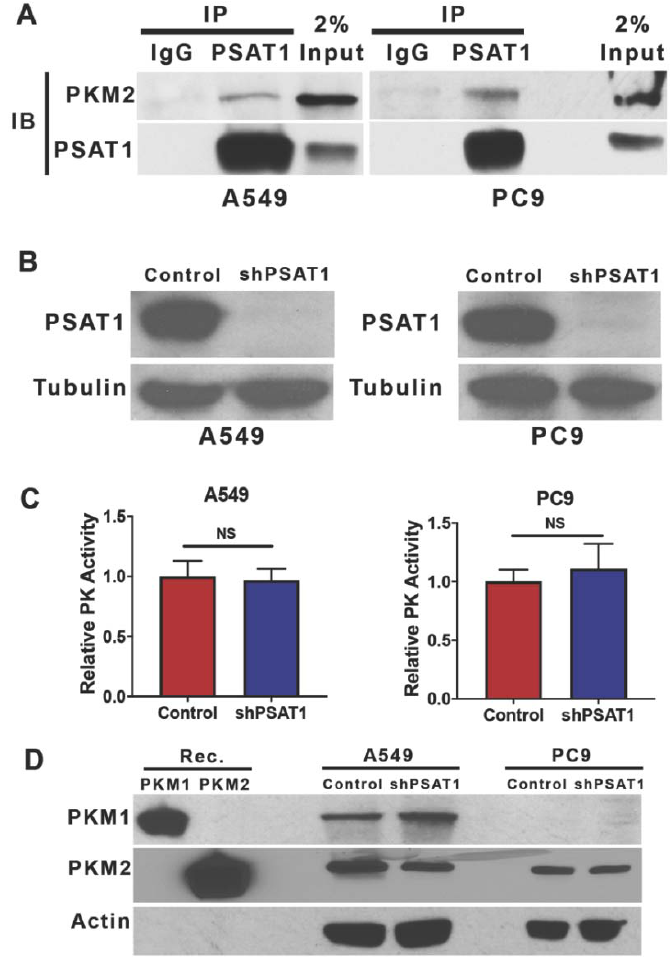
Figure 3. PSAT1 associates with endogenous PKM2 in NSCLC cells but the loss of PSAT1 does not alter either PKM2 expression or pyruvate kinase activity. ( A ) Co-IP of PSAT1 and PKM2 in A549 and PC9 NSCLC cells. PSAT1-specific immunocomplexes were precipitated using anti-PSAT1 from a whole-cell lysate and analyzed for PKM2 by immunoblot with an anti-PKM2 antibody. Shown are representative images from three separate experiments. ( B ) Loss of PSAT1 expression in A549 and PC9 cells stably expressing PSAT1 ‐ specific shRNA. The PSAT1 expression was determined in whole ‐ cell lysates from the control or shPSAT1 ‐ expressing cells by immunoblot using anti ‐ PSAT1 and anti ‐α‐ tubulin (loading control). ( C ) Intracellular pyruvate kinase activity was determined in cell lysates from A549 or PC9 cells with or without PSAT1 expression. Data are represented as relative pyruvate kinase (PK) activity (control cells set to 1) and shown are the mean ± SD from four independent experiments. A statistical significance was determined by an unpaired t ‐ test analysis. ( D ) Immunoblot analysis of PKM1 or PKM2 expression in whole ‐ cell lysates from the control or PSAT1 ‐ silenced A549 and PC9 cells. Recombinant human PKM1 and PKM2 proteins were used as